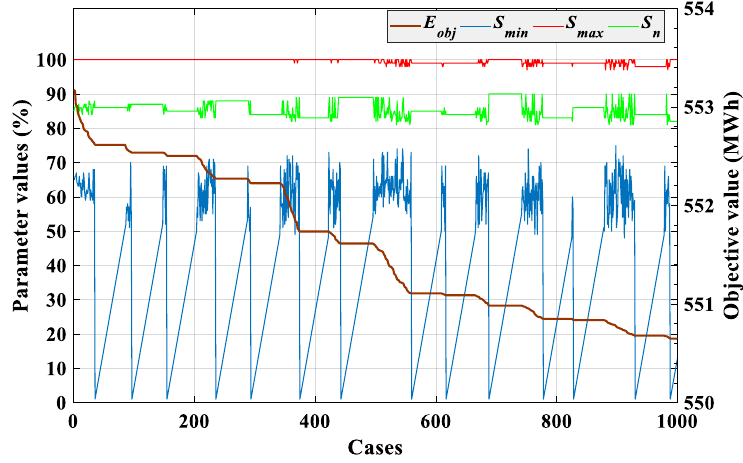
Figure 11. Trends sorted by objective function out of 152,096 cases.